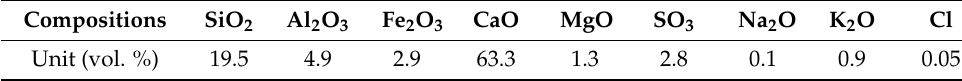
Table 1. Cement chemical composition [59].